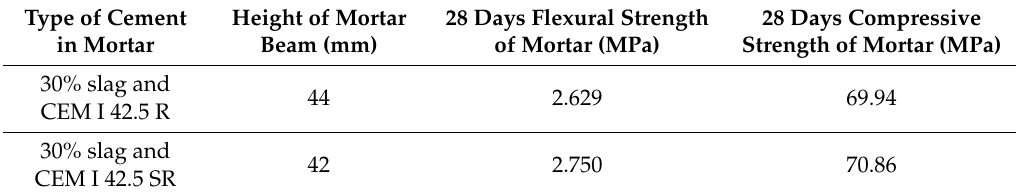
Table 9. Strength tests–slag accounts for 30% by weight of cement